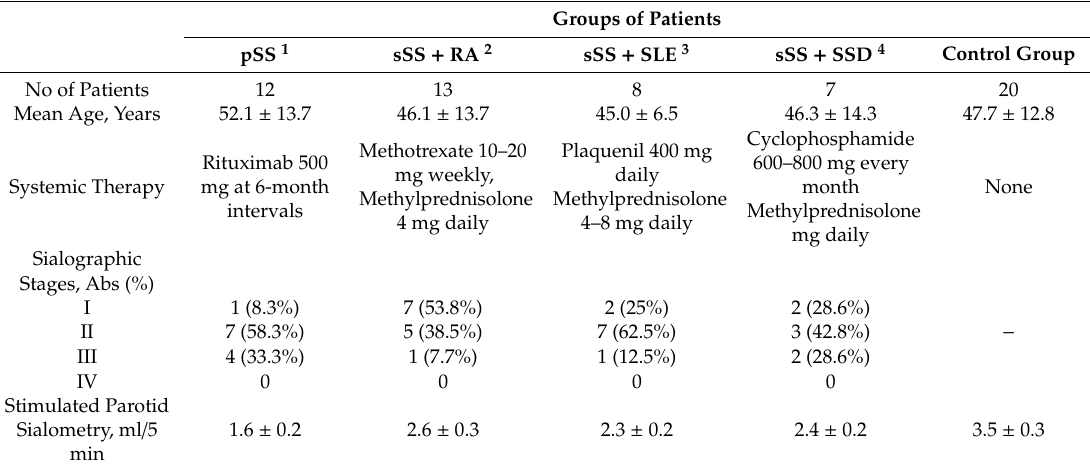
Table 1. Main characteristics of